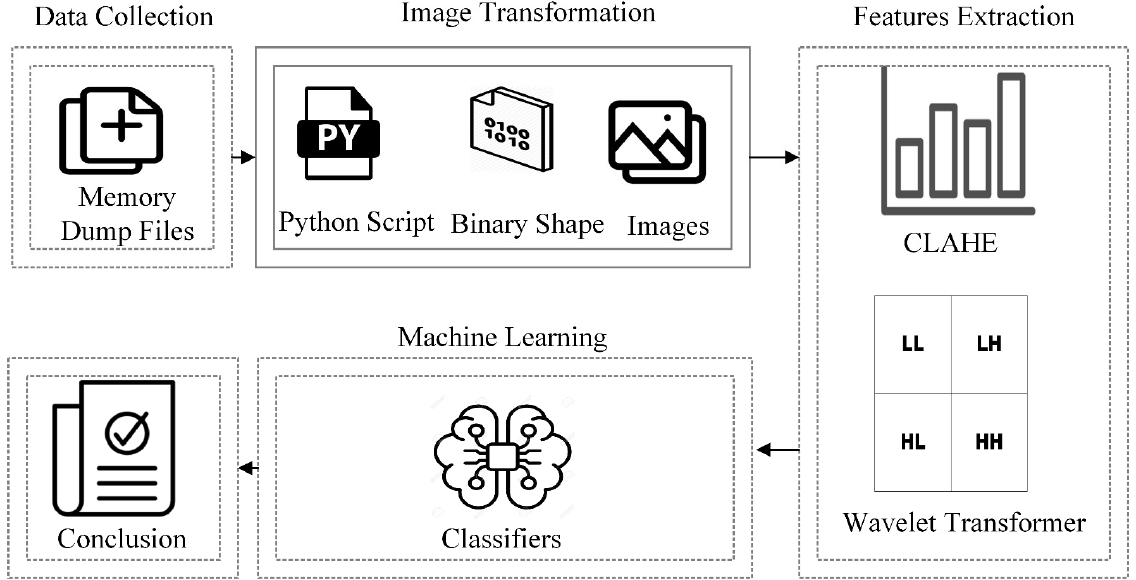
Figure 4. Our Proposed technique to detect malware that resides in main computer memory.